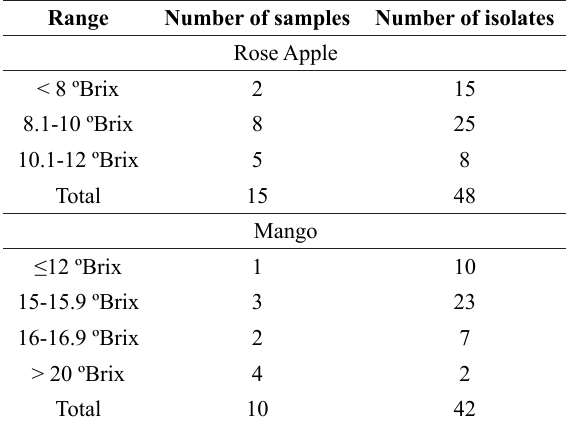
Sample distribution by Brix degrees ranges and number of isolates for each selected sample and